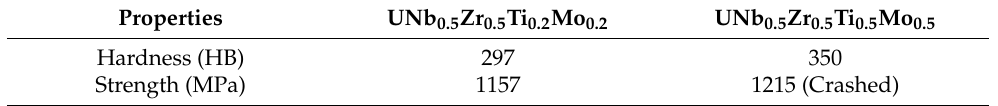
Table 9. Hardness and strength of the UNb 0.5 Zr 0.5 Ti x Mo x HEAs.